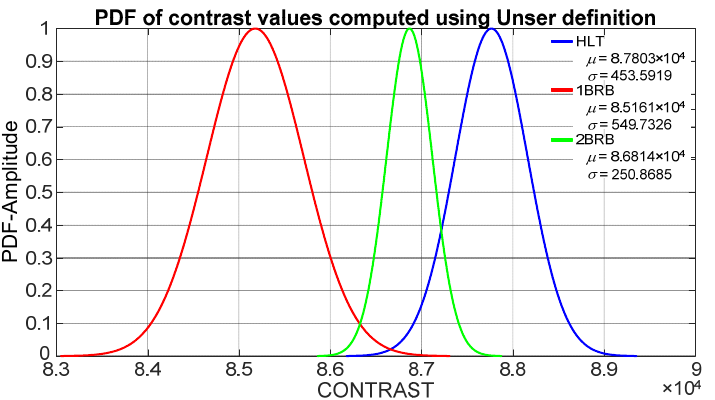
Figure 6. PDFs from contrast values computed through Unser definition for a healthy motor (HLT),